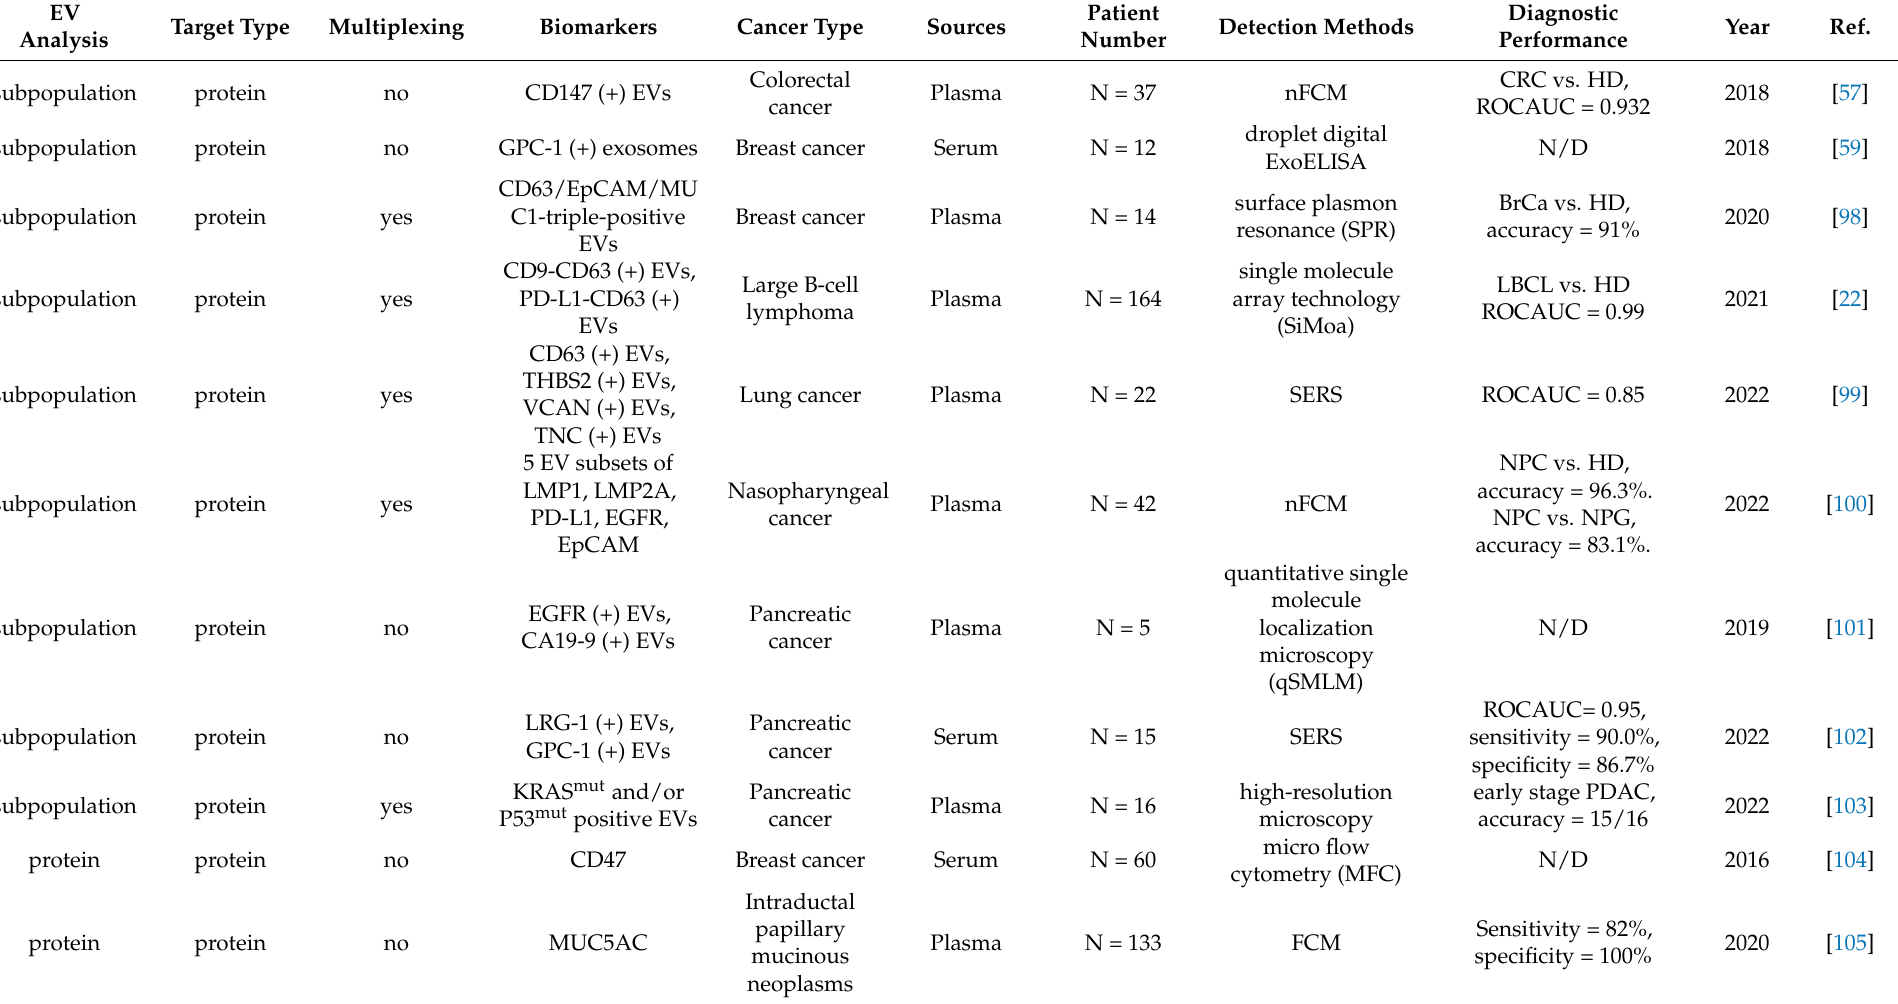
Table 2. Clinical applications of the single EV analysis in early cancer